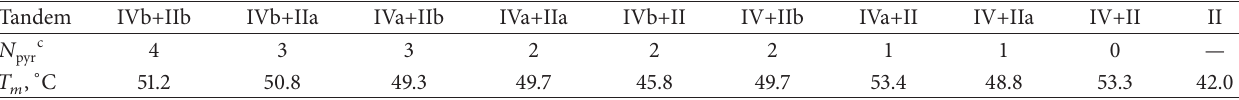
Table 2: Thermal stability a of duplexes between tandem probes and their components with fcDNA target b .